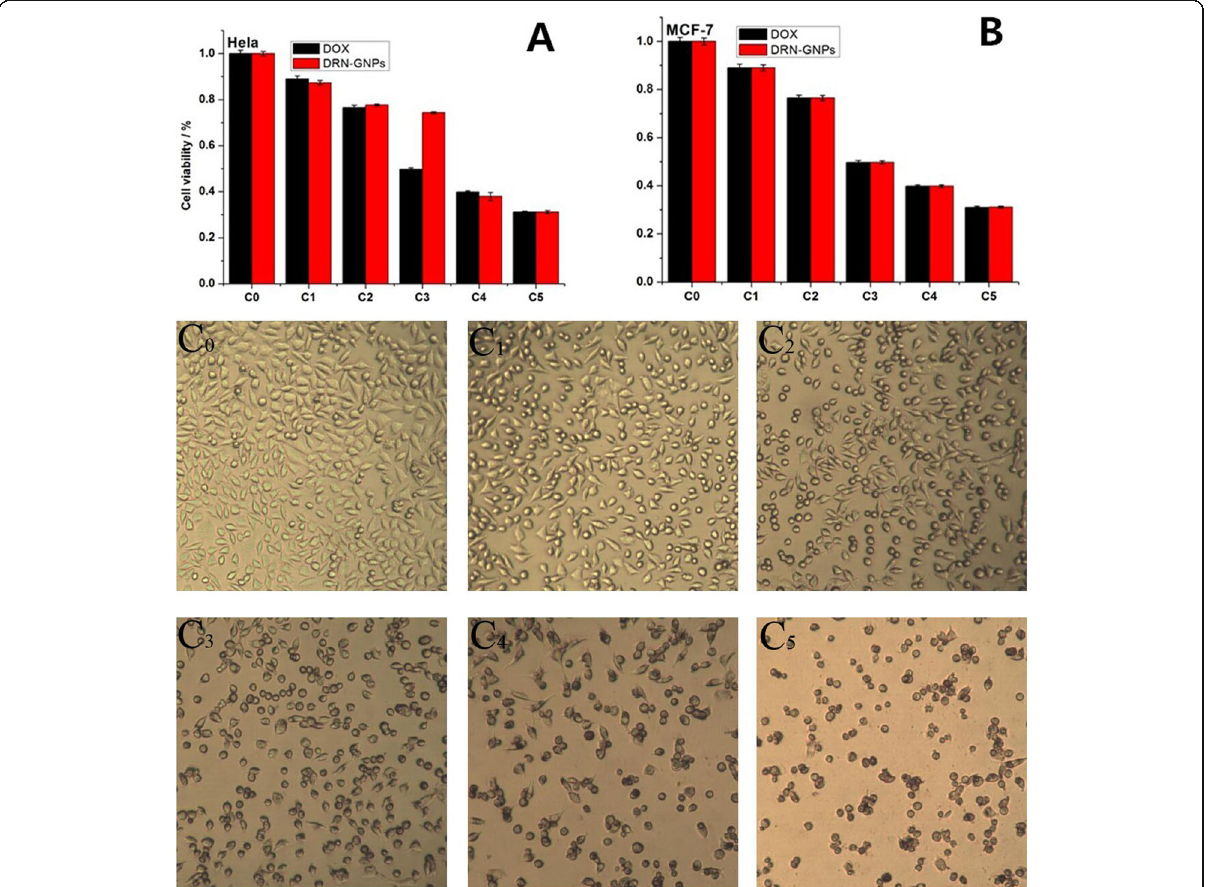
Fig. 6 MTT assay was used to qualitatively display in vitro anti-tumor activity of DOX and DRN-GNPs on Hela ( a ) and MCF-7 cells ( b ) for 24 h (100%). The concentrations of C 0 -C 5 are 0, 20, 40, 60, 80, 100 μ g/mL for DRN-GNPs; the corresponding DOX ’ s concentrations are 0, 7.8, 15.6, 23.4, 31.2, 39.0 μ g/mL. Data are represented as means ± standard deviations of triplicate samples ( n = 3). Images of Hela cells incubated with different concentration of DRN-GNPs ( c